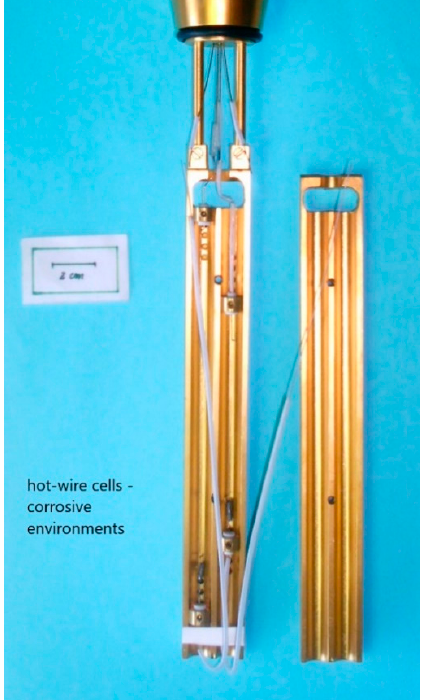
Figure 3. TiN film protection of TWH instrument for humid air measurements—detail of hot-wire cells. Hot-wire was made from tungsten (diameter 8.94 ± 0.05 µ m, long wire length 148.92 ± 0.02 mm and short compensating wire length 71.69 ± 0.02 mm). The global uncertainty of the measurement, at a 95% confidence level, was estimated to be U λ = 1.7%. Adapted from [35].